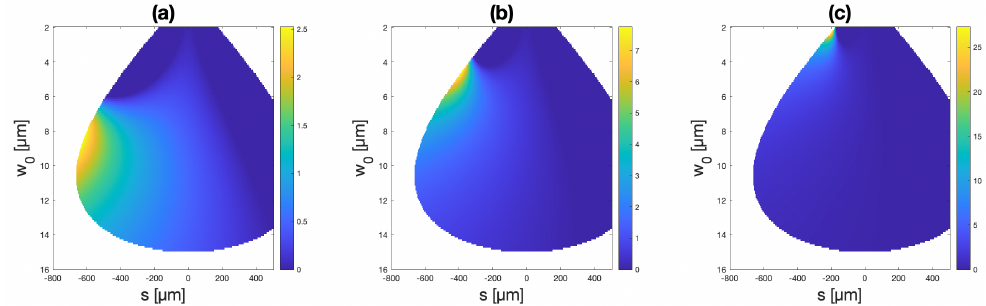
Figure 6. Relative focal shift simulation results for 30 µ m membranes and maximum deflections of ( a ) 50 nm ( b ) 100 nm, and ( c ) 200 nm. The colormaps represent focal shifts normalized by the Rayleigh range of the incident beam.